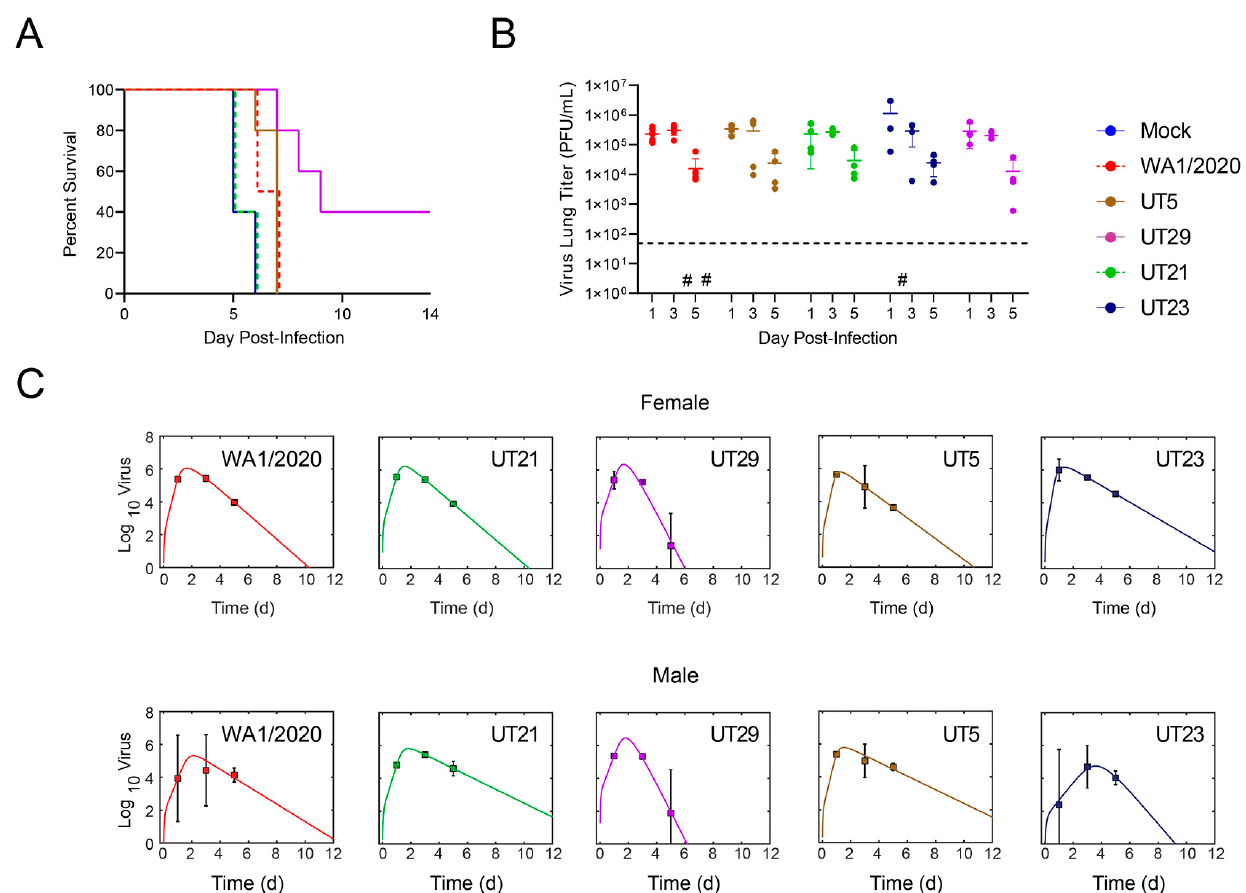
Figure 3. ( A ) Survival curves of female K18-hACE2 mice that were intranasally challenged at 1 × 10 4 PFU with either SARS-CoV-2 WA1/2020 ( n = 4) or one of four clinical isolates UT5, UT21, UT23, or UT29 ( n = 5). The study was completed at 14 dpi. ( B – C ) K18-hACE2 mice (50:50 male: female) were intranasally challenged with either a mock, SARS-CoV-2 WA1/2020, or one of four clinical isolates at 1 × 10 4 PFU, and were euthanized on 1, 3, or 5 dpi ( n = 4 per timepoint). ( B ) The virus titer in the left lobe of the lung was measured via plaque assay (PFU/mL of half of the lung homogenate). The limit of detection of the plaque assay (horizontal dashed line) is 50 PFU. The symbol (#) represents one individual mouse without a measurable virus titer. ( C ) Fit of the viral kinetic model (Equations (S1)–(S4), Supplementary A) to viral loads from the lungs of female mice (top panel) and male mice (bottom panel) of WA1/2020 (red), UT21 (green), UT29 (violet), UT5 (brown), or UT23 (navy blue). Data are shown as geometric mean and standard deviation.